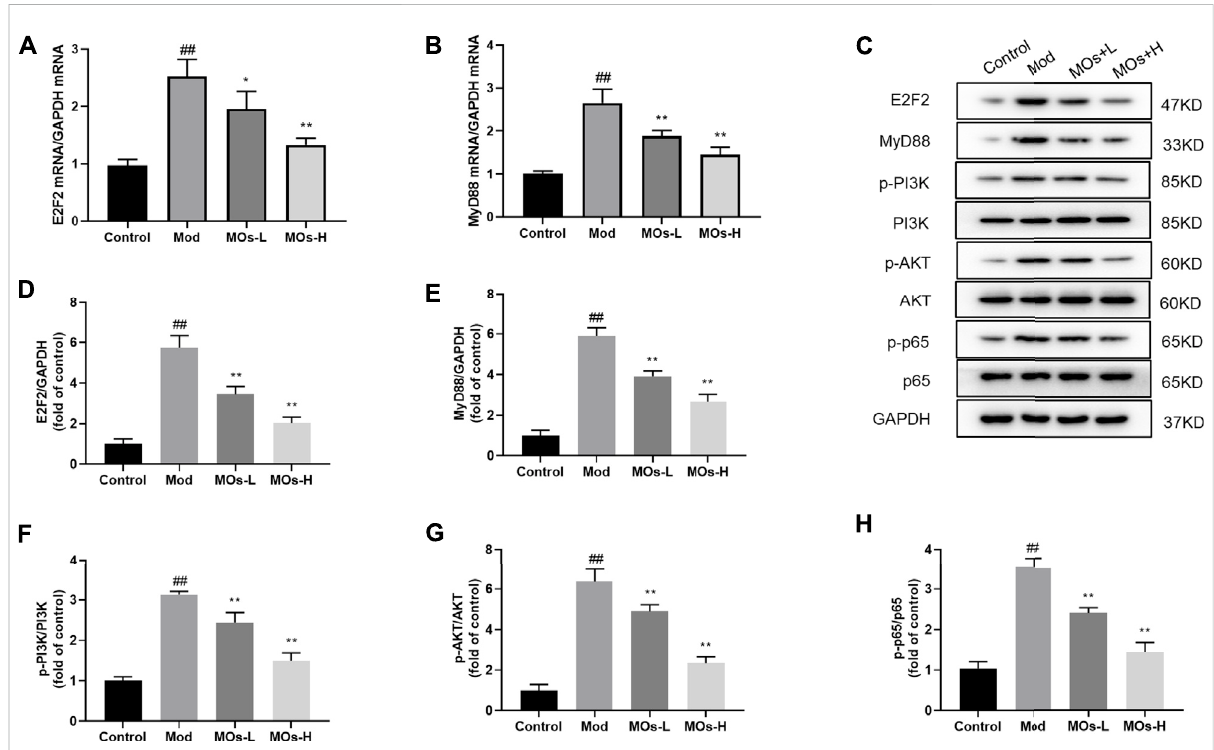
FIGURE 4 EffectsofMOsonE2F2-regulatedMyD88/PI3Kpathwayinthehippocampus. (A – B) qRT-PCRanalysisofgeneexpressionofE2F2andMyD88in hippocampus tissues. (C – H) Immunoblot analysis of E2F2, MyD88, p-PI3K, p-AKT and p-NF- κ B p65 in hippocampus tissues. Data are expressed as means ± SD ( n = 3). ## p < 0.01 vs. control; * p < 0.05; ** p < 0.01 vs.